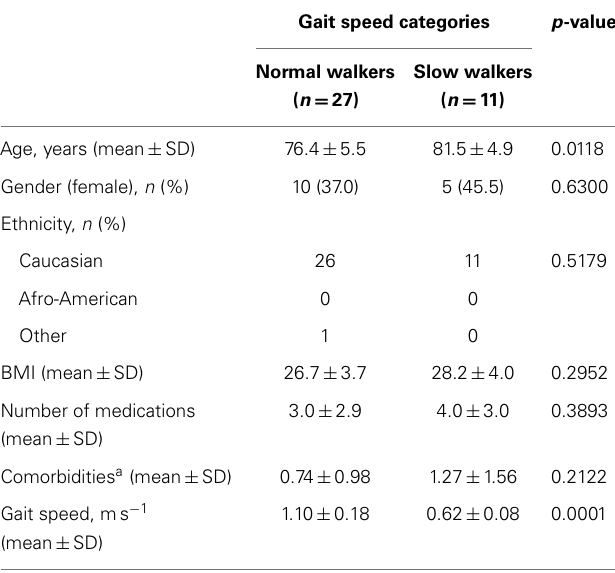
Table 1 | Descriptive characteristics of the study population according to gait speed categories